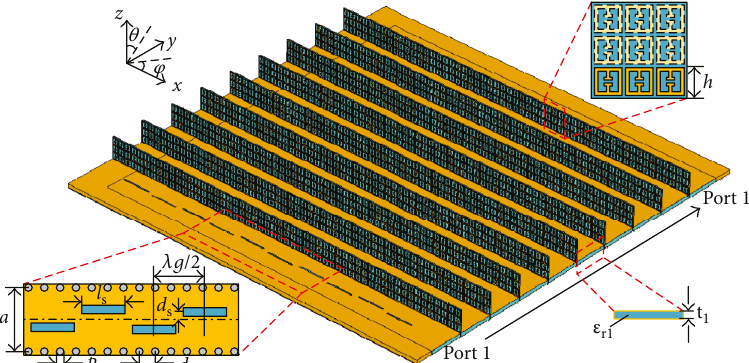
Figure 1: Con fi guration of the proposed 10 × 10 SIW slot array antenna covered with an ELC metasurface: p = 0 5 mm , d = 0 9 mm , and a = 15 0mm